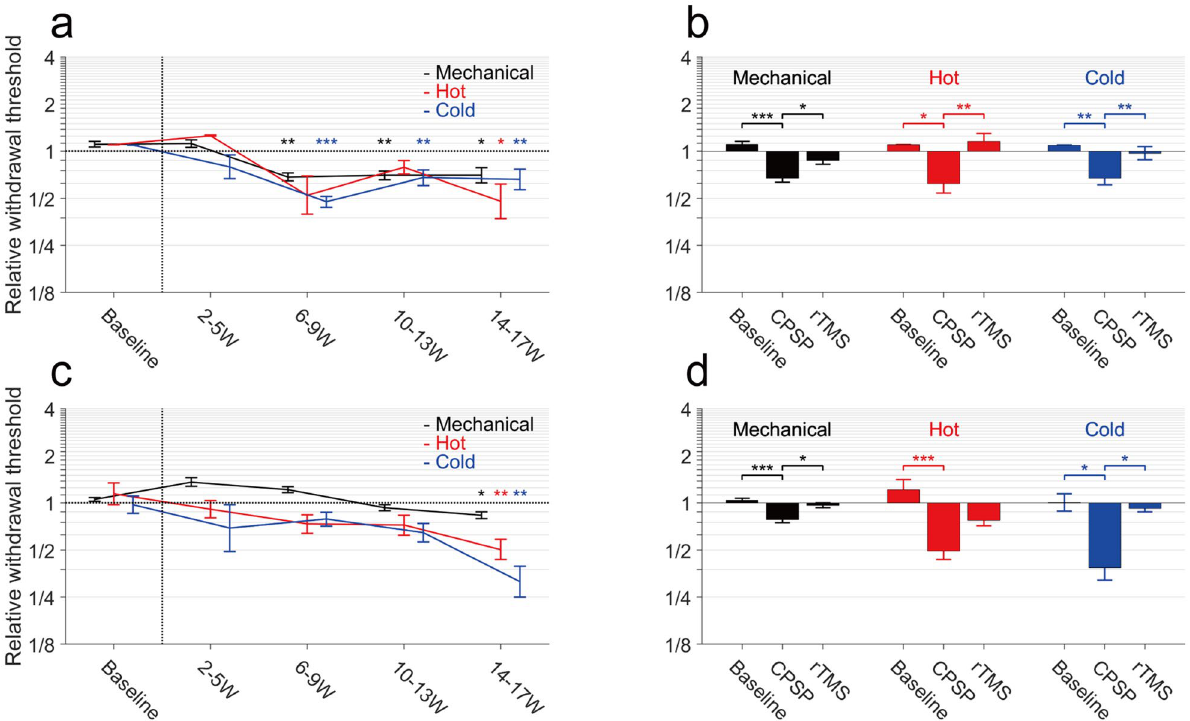
Figure 2. Behavioural changes after lesion and post rTMS treatment. Medians and interquartile ranges for the relative withdrawal threshold of the affected side (contralateral to the lesion) against the unaffected side (ipsilateral to the lesion) are shown. ( a , c ) The changes in relative withdrawal latency to mechanical (black) and thermal stimulation (red: hot, blue: cold) are shown before and after lesion induction for monkey 1 ( a ) and monkey 2 ( c ). After 14 weeks following the injection, the relative withdrawal latency for all stimulations significantly decreased relative to those before the injection. ( b , d ) Comparison of the withdrawal thresholds for the prelesion baseline, CPSP condition, and after rTMS treatment for monkey 1 ( b ) and monkey 2 ( d ). After the rTMS treatment, the reductions were recovered to the baseline without monkey 2 against hot stimulation. * p < 0.05, ** p < 0.01 and *** p < 0.001, based on Kruskal–Wallis test followed by Dunn’s post hoc analysis ( a , c ), and based on Wilcoxon signed-rank test ( b , d ). CPSP central poststroke pain, rTMS repetitive transcranial magnetic